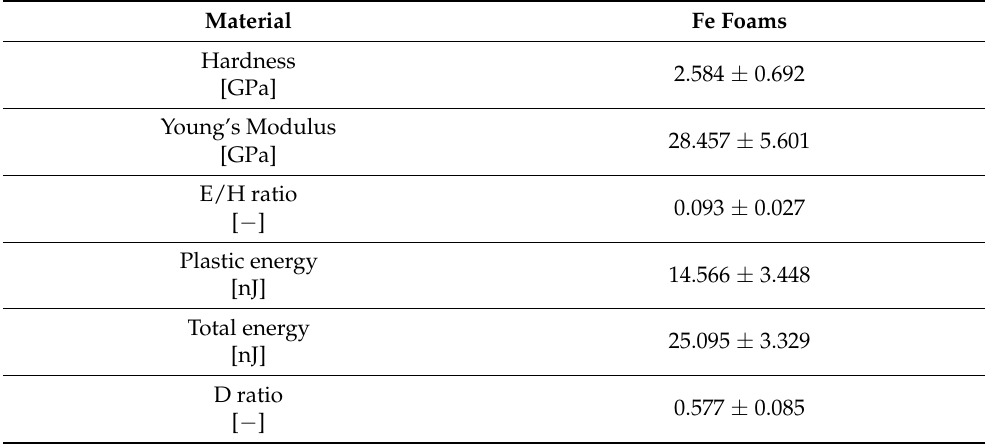
Table 2. Nanomechanical properties and energy calculation results for Fe foam with standard deviation ( n =